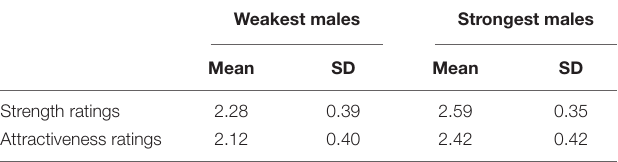
TABLE 5 | Female ratings of male voices.